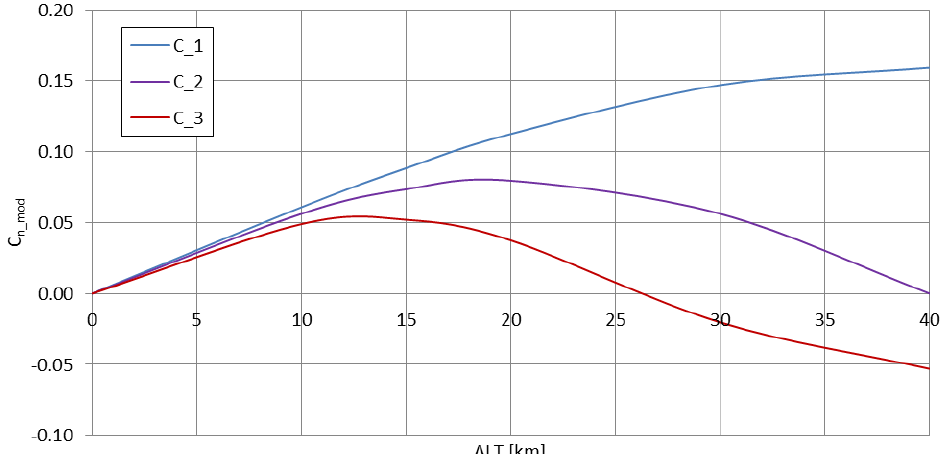
Figure 1. VLF propagation mode magnitudes (1st, 2nd, and 3rd) plotted as a function of the emitter’s altitude.